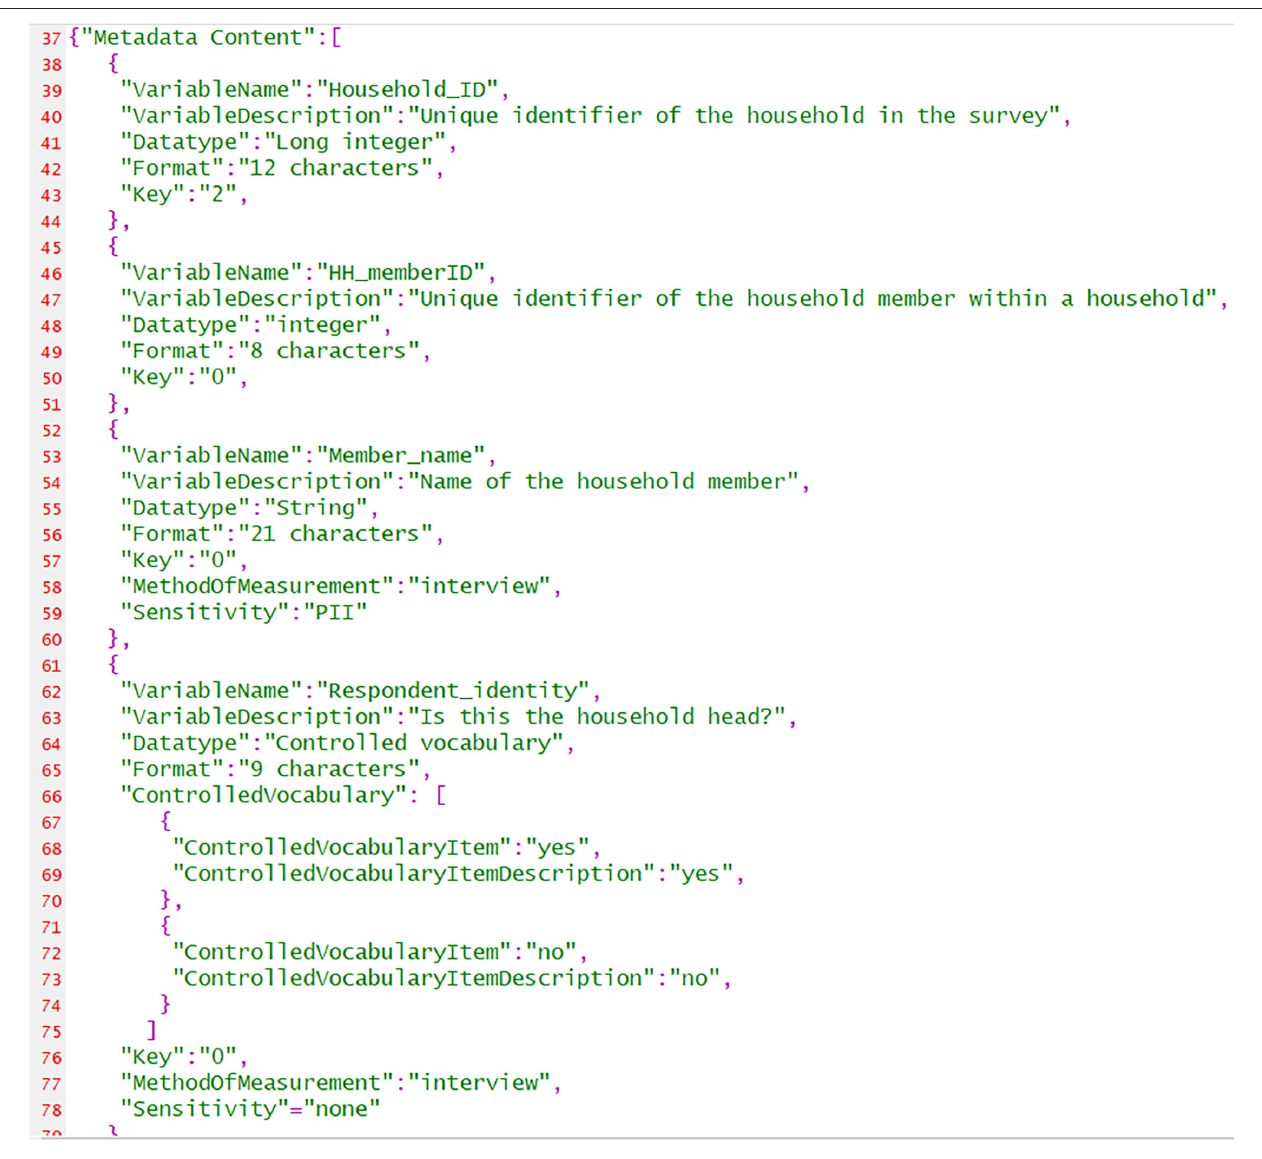
FIGURE 5 | Portion of the JSON file containing the data dictionary in OIMS format.